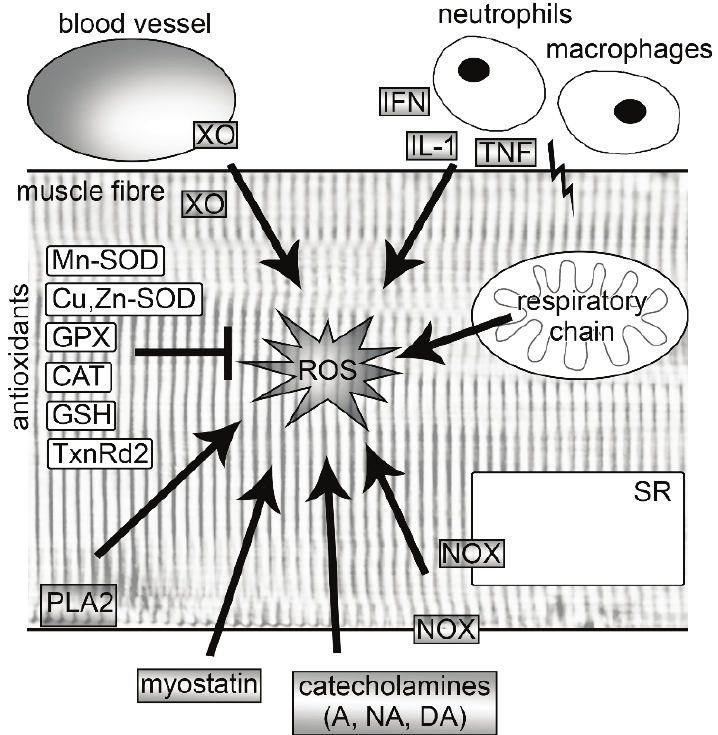
Figure 1. Sources of reactive oxygen species (ROS) and endogenous antioxidants in skeletal muscle fibers. Following exercise, ROS are produced endogenously by mitochondria, NOXs, PLA2 and XO. In addition, exercise increases ROS production also in activated neutrophils and macrophages, endothelia of blood vessels and by catecholamines. Regular exercise leads to an increase of endogenous antioxidants, which are able to neutralize free radicals. A, adrenaline; CAT, catalase; Cu, Zn-SOD, copper-zinc superoxide dismutase; DA, dopamine; GPX, glutathione peroxidase; GSH, glutathione; IFN, interferon (cid:3); IL-1, interleukin-1; Mn-SOD, manganese superoxide dismutase; NA, noradrenaline; NOX, nicotinamide adenine dinucleotide phosphate oxidase; PLA2, phospholipase A2; SR, sarcoplasmic reticulum; TNF, tumor necrosis factor; TxnRd2, thioredoxin reductase 2; XO, xanthine